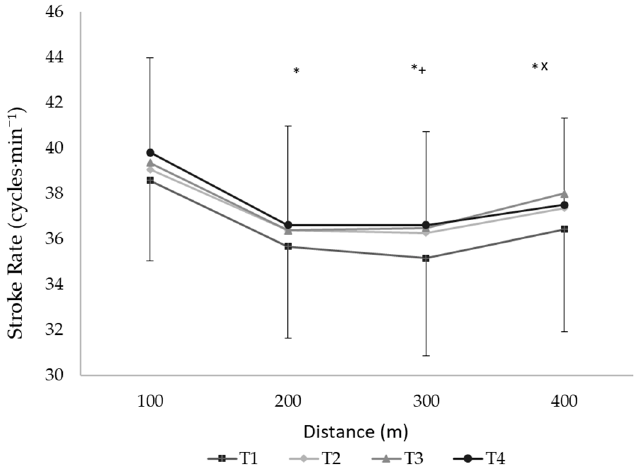
Figure 2. The stroke rate in each 100 m split of the 400 m front crawl effort at testing moments T1, T2, T3, and T4. T1: beginning of the first macrocycle; T2, T3, and T4: end of the first, second, and third macrocycles, respectively. * and +: p < 0.05 compared to 100 m and 400 m.